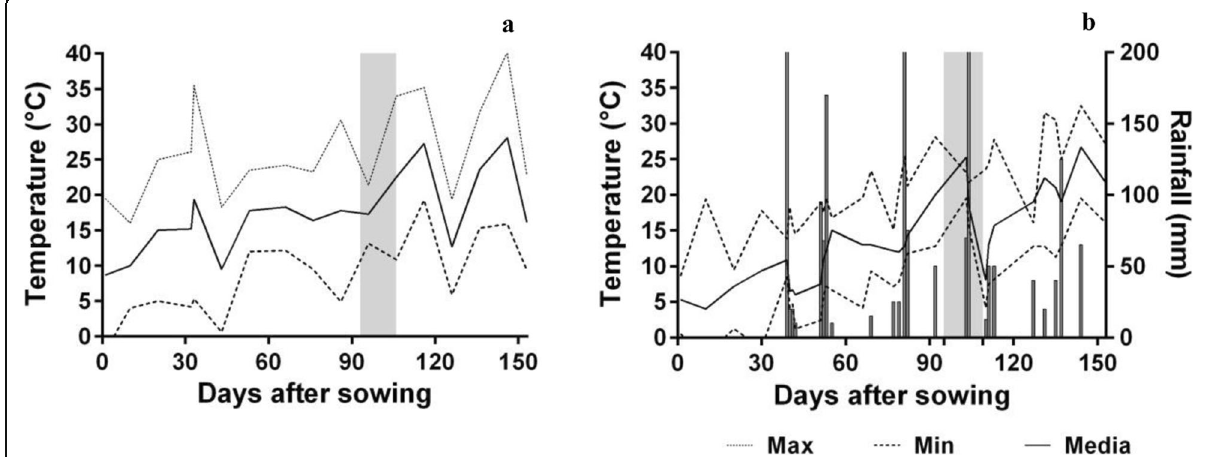
Fig. 6 Temperature and rainfall after sowing in the field. a San Juan (EXP4). b Bordenave (EXP5). The dotted lines correspond to the minimum and maximum temperatures, and the continuous line corresponds to the mean. *The gray zone shows the flowering period